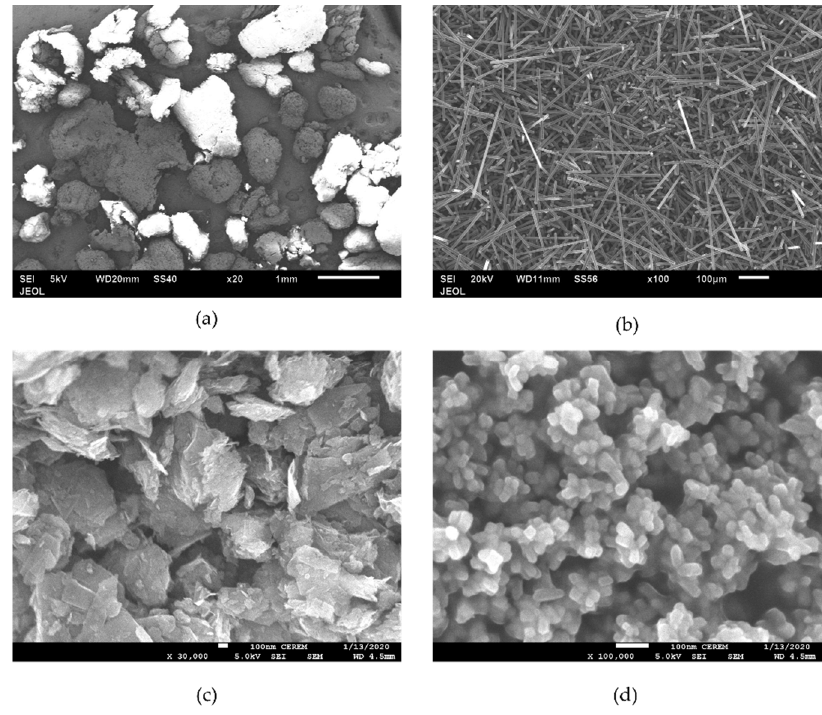
Figure 1. SEM images of raw materials ( a ) PP23, ( b ) SCF, ( c ) GNP, and ( d ) nTiO 2 .